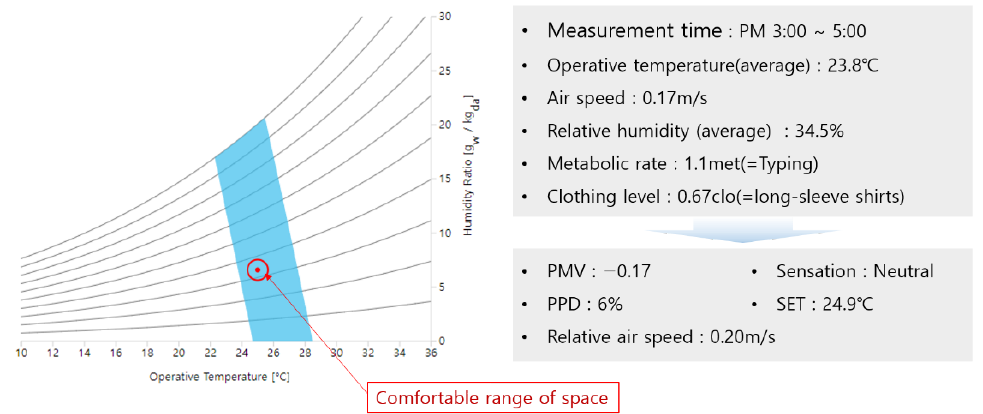
Figure 6. Indoor air quality measurement of one-person office space: one-person office space comfort level analysis result as of 20 April